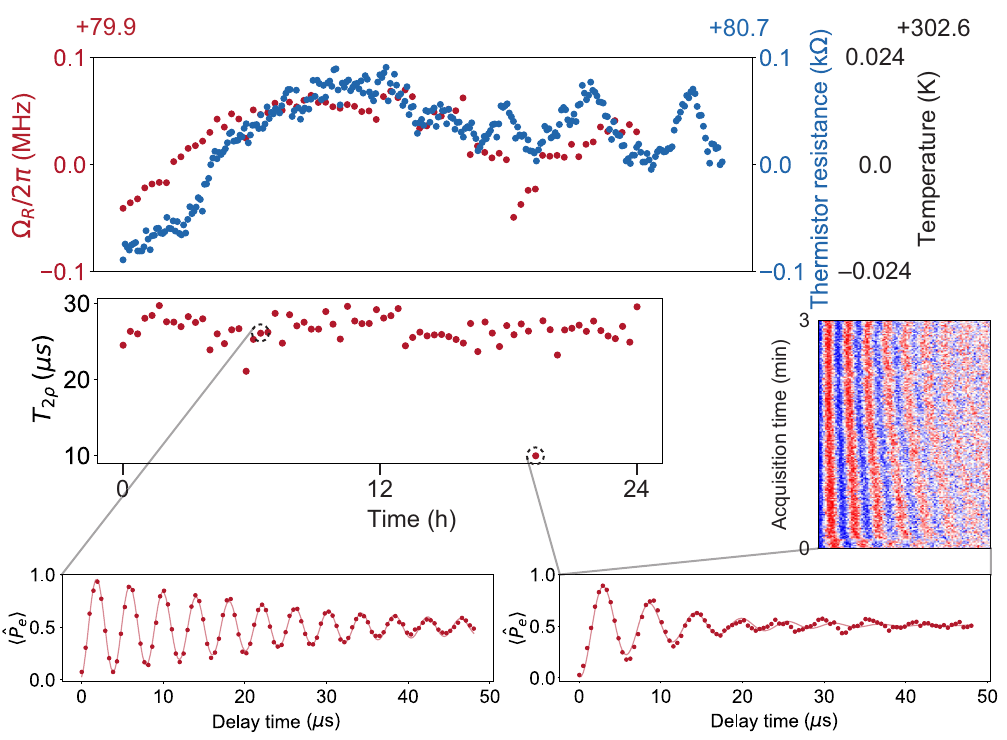
FIG. 7. Tracking system stability over time. Top panel: simultaneous measurements of the Rabi frequency and the ambient temperature (inferred from the measured thermistor resistance) where the active microwave components are held. The data shows that the two are correlated. Middle panel: extracting driven coherences T 2 ρ suggests a stable amplitude noise spectrum within an acquisition 3 min (bottom left-hand panel: a typical time-domain Ramsey trace), with a single instance where the amplitude drift was time τ acq ¼ large (bottom right-hand panel), as confirmed via looking at the raw data binned 10 shots at a time over τ